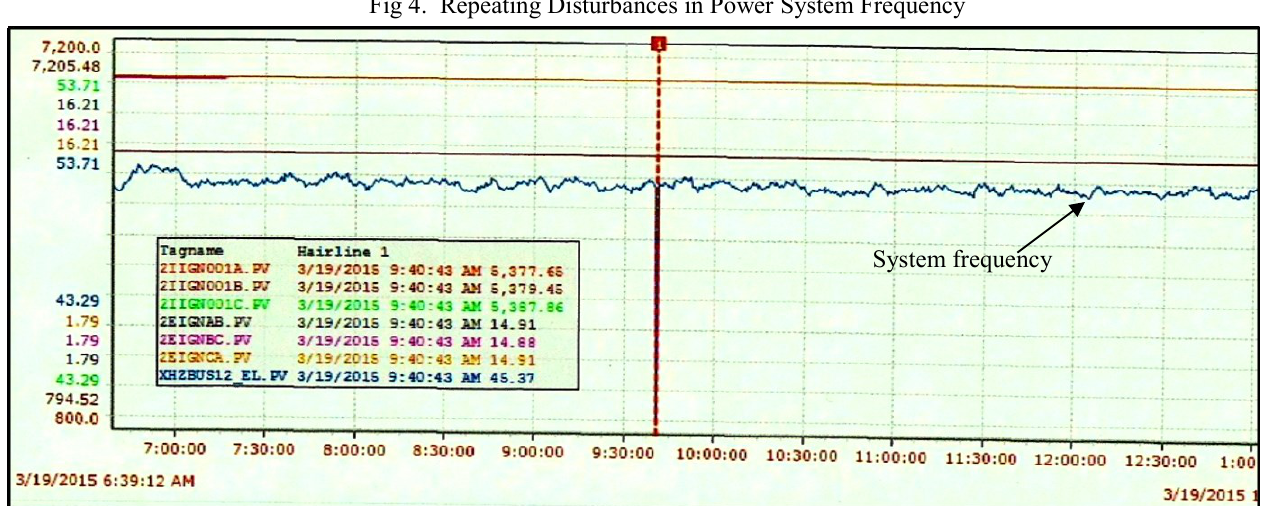
Fig 5. Instantaneous Decrease in Power System